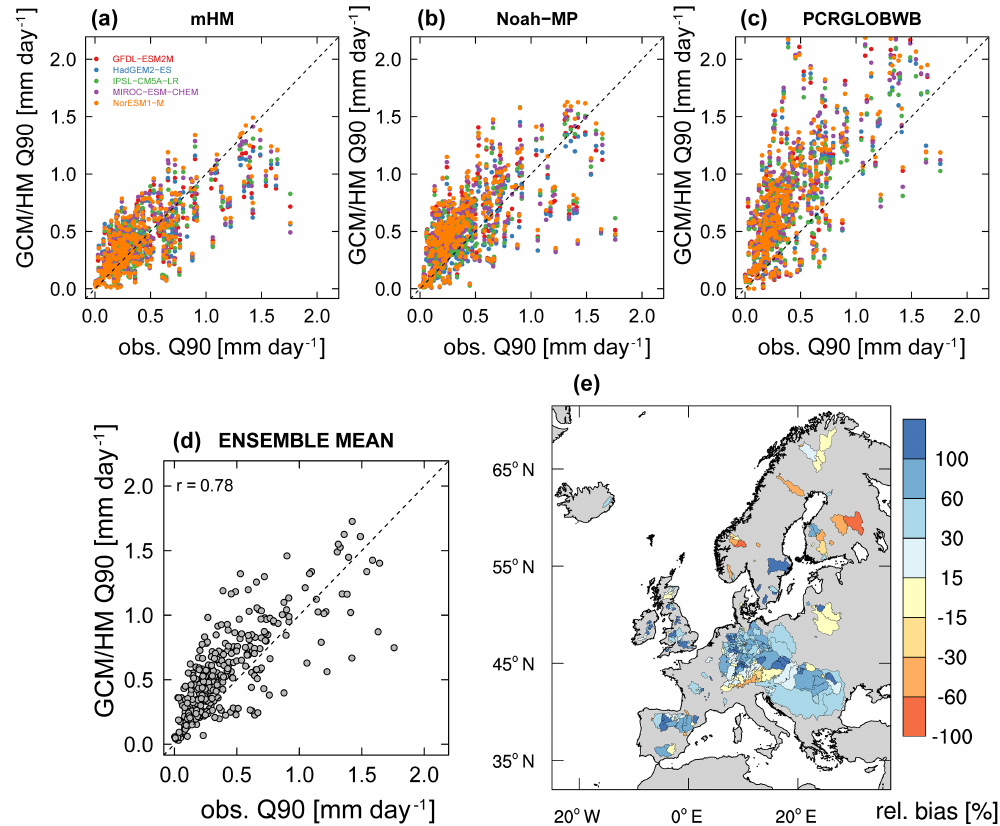
Figure 1. Scatter plot between observed low flow and GCM/HM simulated low flow (Q90) over 357 gauges across Europe. Simulated values correspond to the median of the annual estimates calculated for the historical time period 1966–1995. The colours of the dots denote the five GCMs used to drive the hydrologic models mHM (left column), Noah-MP (middle column), and PCR-GLOBWB (right column). The location of the basins and the spatial pattern of the relative bias is shown on the lower right. Table 1. Determination of 1.5, 2, and 3K time periods for different GCM/RCP combinations. A time-sampling approach was used